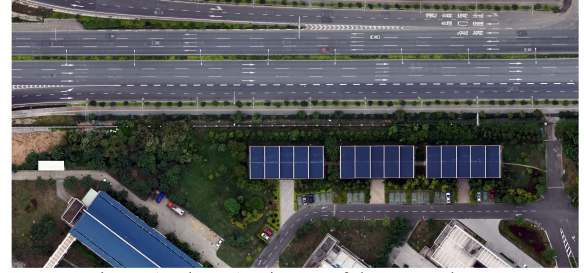
Figure 1. The UAV image of the research